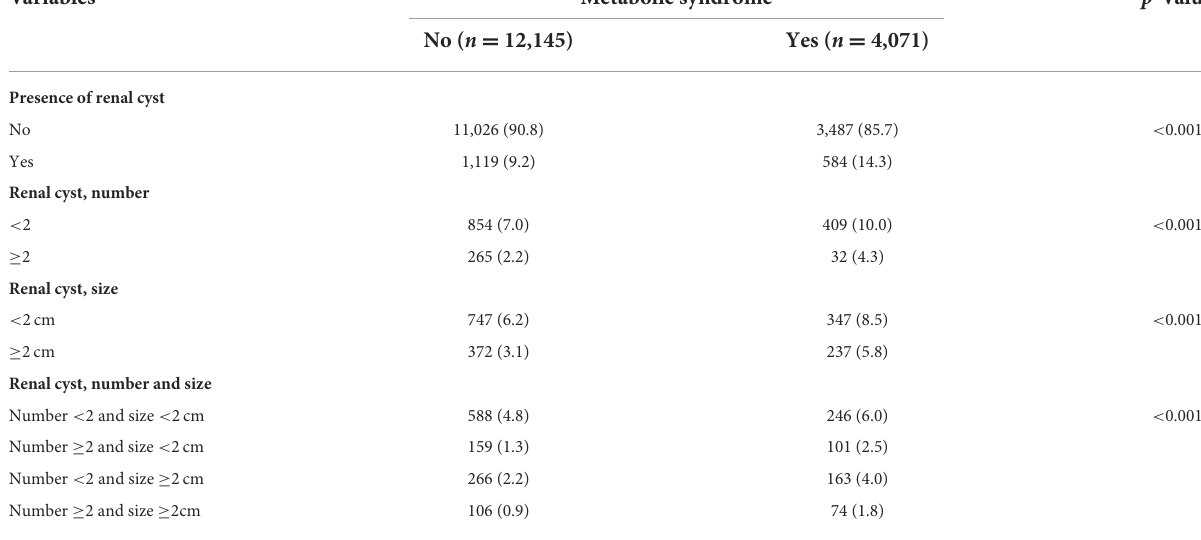
TABLE 2 Relationship between metabolic syndrome and renal cyst by Pearson Chi-square